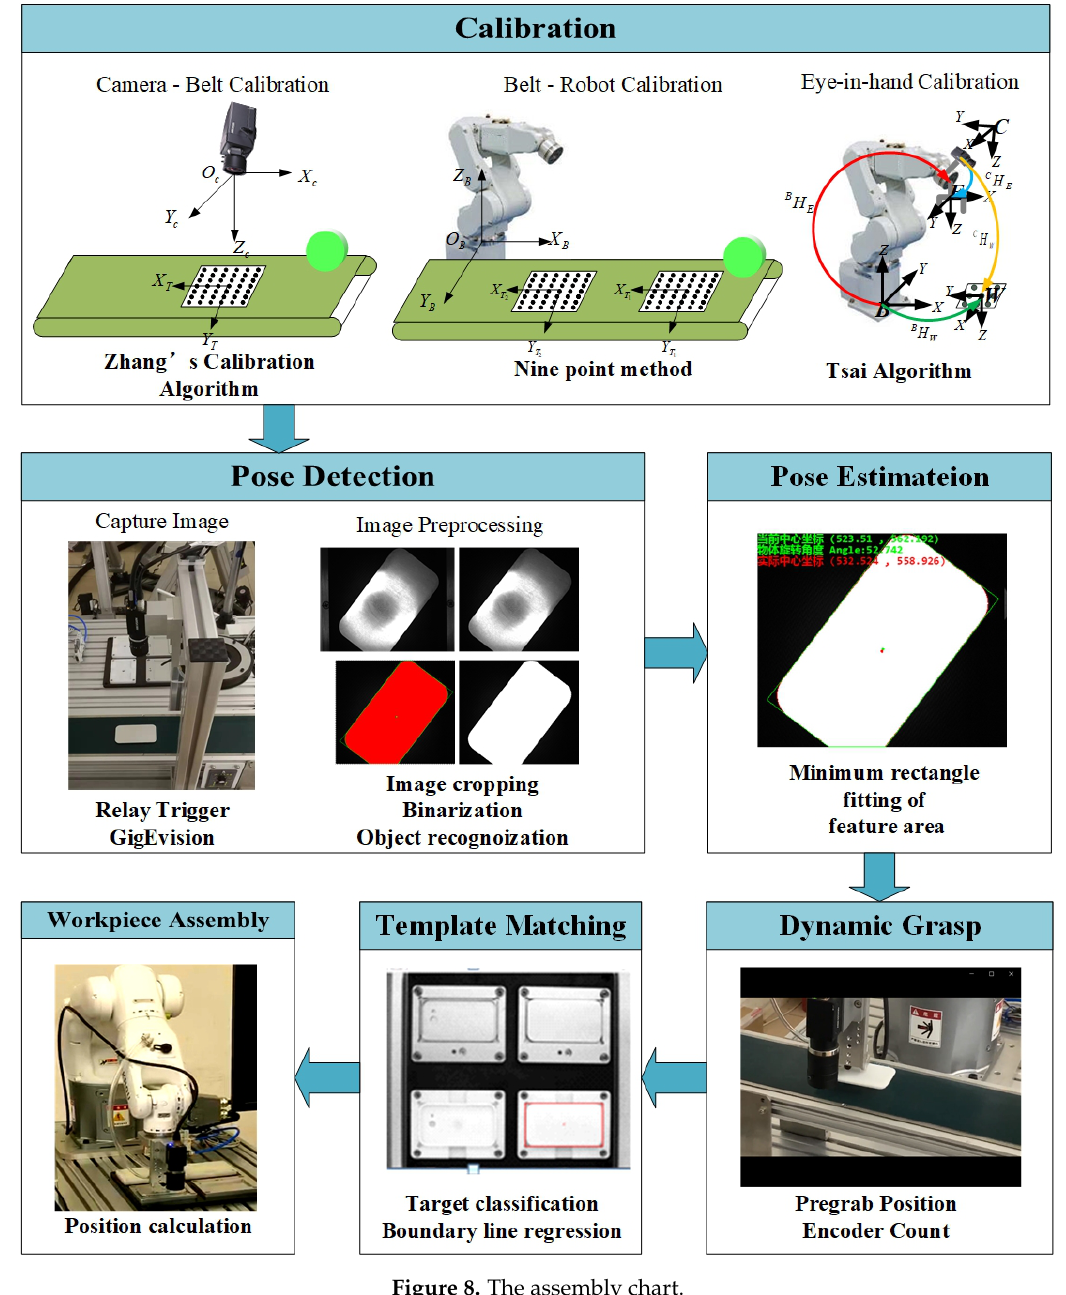
Figure 8. The assembly